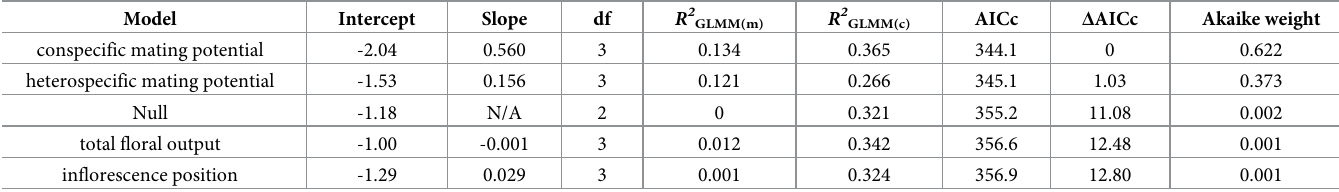
Table 3. Summary of model selection results for fertilization rate in C . scandens .